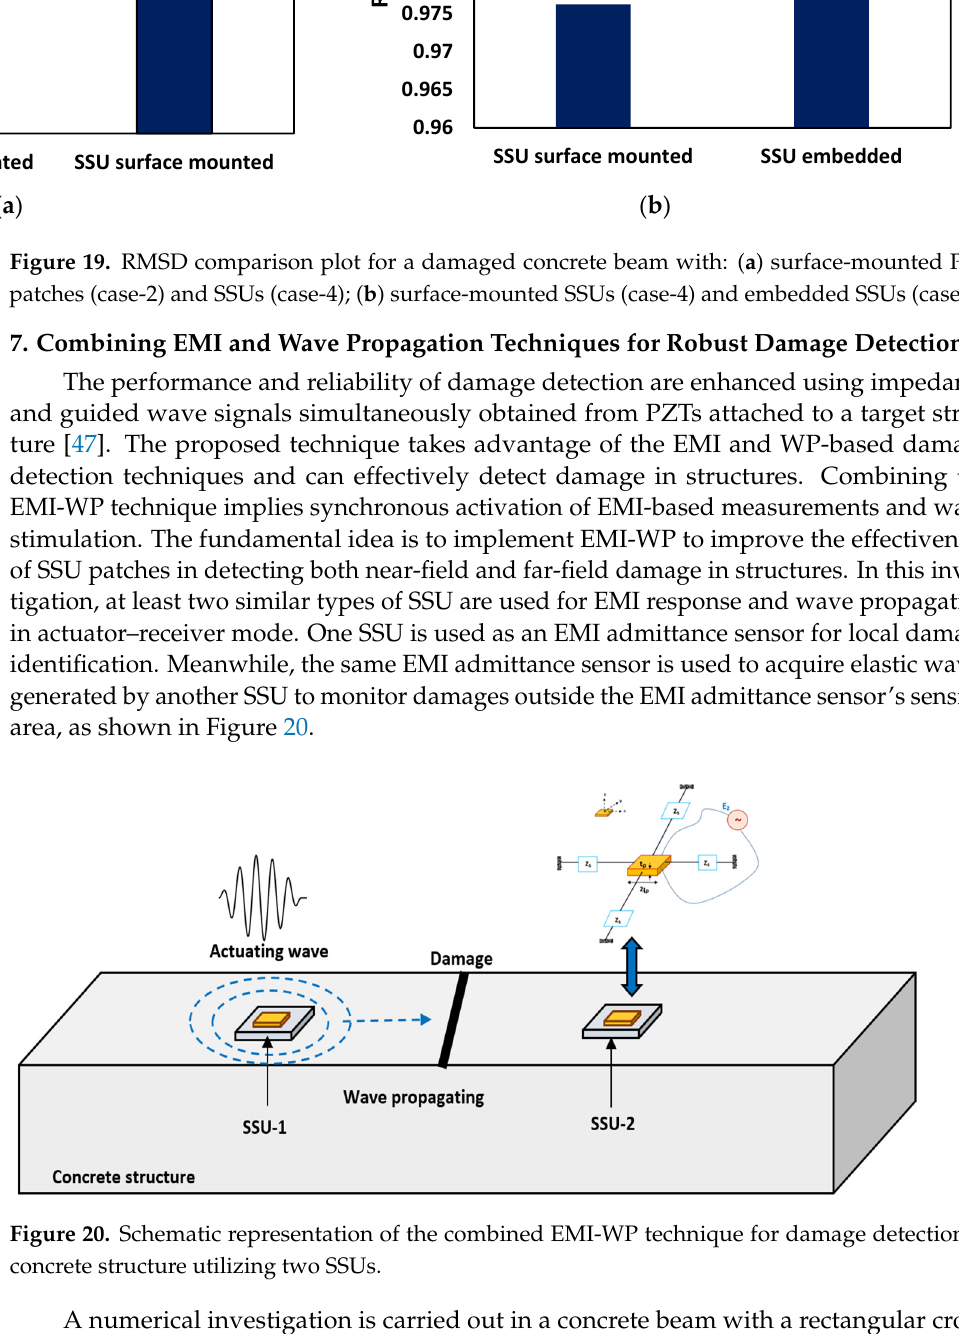
18 of 26 Figure 18. Damaged concrete beam with embedded SSU: ( a ) Schematic 3D model; ( b ) FE model; ( c ) Response spectrum obtained from wave propagation measurements in the actuator–receiver mode; ( d ) Comparison of received signal between the damaged and no damaged concrete beam with the applied actuation signal. The statistical metric to quantify the changes in the waveform is employed using root mean square deviation (RMSD) expressed as: RMSD = (cid:3496)∑(𝑥 (cid:3036)(cid:3042) − 𝑥 (cid:3036)(cid:2869) ) (cid:2870) ∑(𝑥 (cid:3036)(cid:3042) ) (cid:2870) (20) where 𝑥 (cid:3036)(cid:3042) is the i th value of reference signature, and 𝑥 (cid:3036)(cid:2869) is the i th value of the compared signature. Figure 19a shows the RMSD plot obtained from the received voltage signal for case-2 ( damaged concrete beam with surface-mounted PZT patches ) and case-4 ( damaged con- crete beam with surface-mounted SSUs ), using the respective undamaged cases as a refer- ence. It is feasible to conclude that utilizing WP response with SSU improves the RMSD